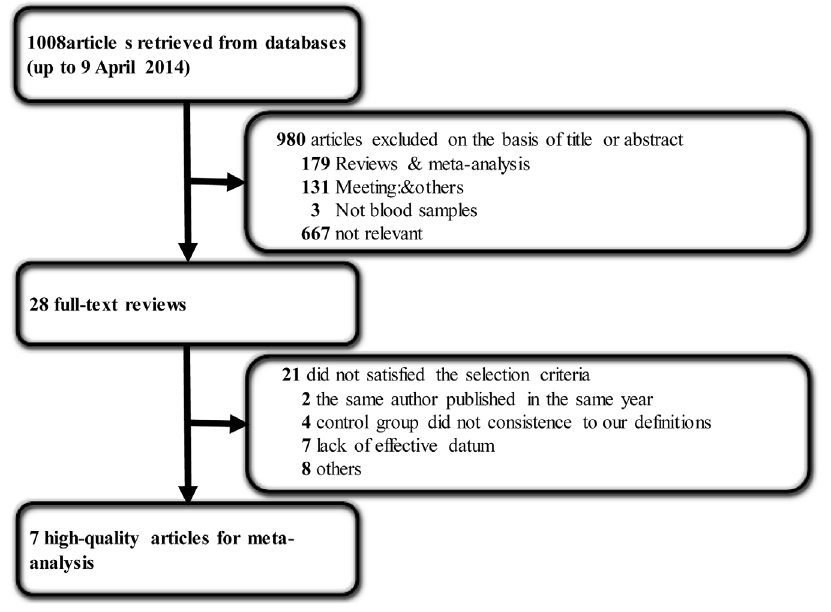
Figure 1. Flow diagram of the selected eligible studies based on the inclusion and exclusion criteria.